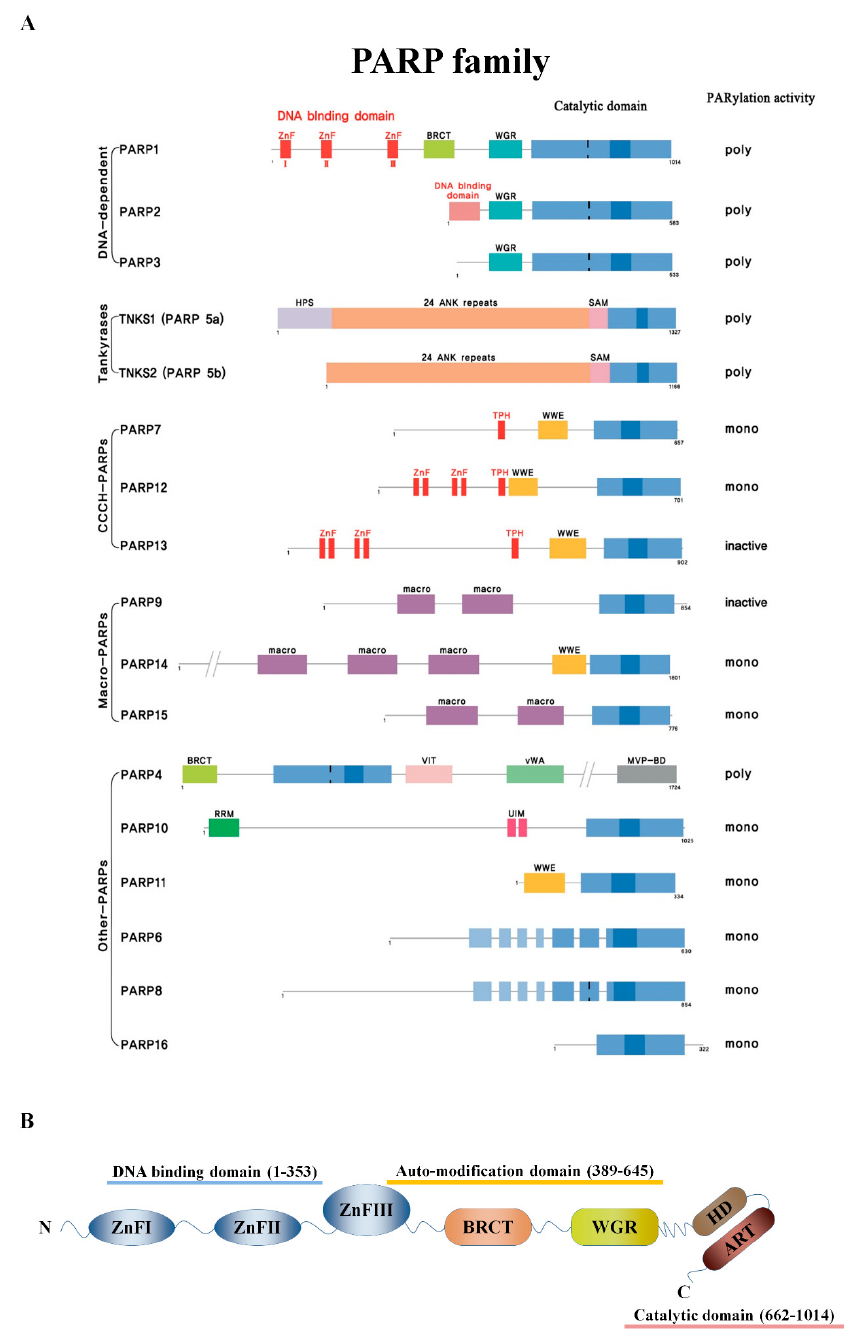
Figure 1. PARPs structure ( A ) The PARP family consists of 17 members, divided into five subgroups according to domain structure and function: DNA damage-dependent PARPs (PARP1, PARP2, and PARP3), tankyrases (tankyrase1 / PARP5 and tankyrase2 / PARP5b), CCCH-type PARPs (PARP7, PARP12, and PARP13), macro-PARPs [B-aggressive lymphoma 1 (BAL1) / PARP9, BAL2 / PARP14, and BAL3 / PARP15], and other PARPs (PARP4, PARP6, PARP8, PARP10, PARP11, and PARP16). The catalytic domain at the C-terminus is conserved in all members and contains additional zinc fingers, BRCA C-terminus-like (BRCT) motifs, ankyrin repeats, macro domains, and WWE domains. ( B ) The seven major domains of PARP1 include three zinc-finger domains in the DNA binding domain, the BRCT domain in the auto-modification domain, and the pADPr accepting WGR domain (W), located centrally. The C-terminus has two catalytic domains: ART and a helical domain